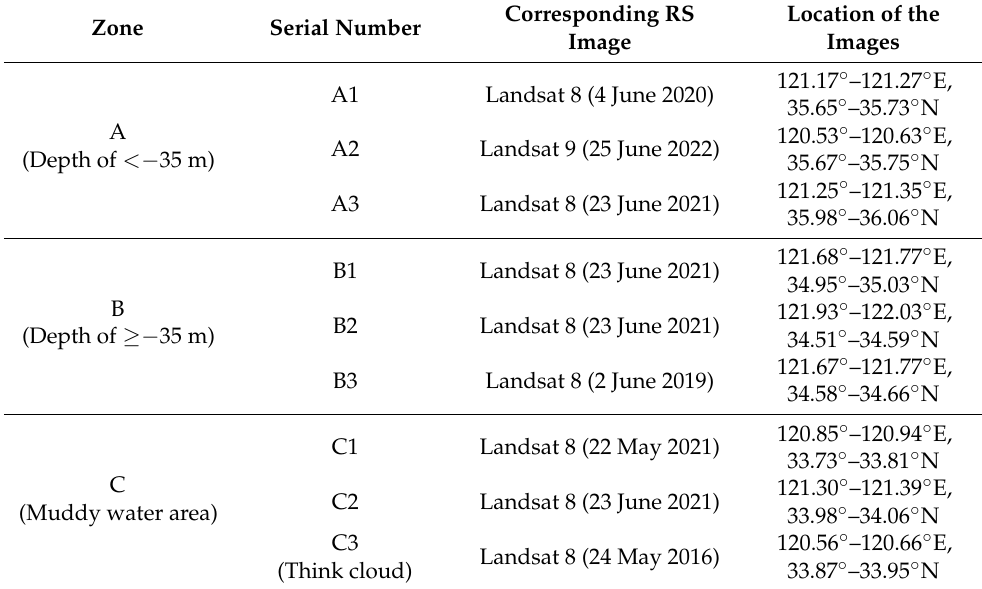
Table 5. Detailed information on RS images for accuracy assessment in different